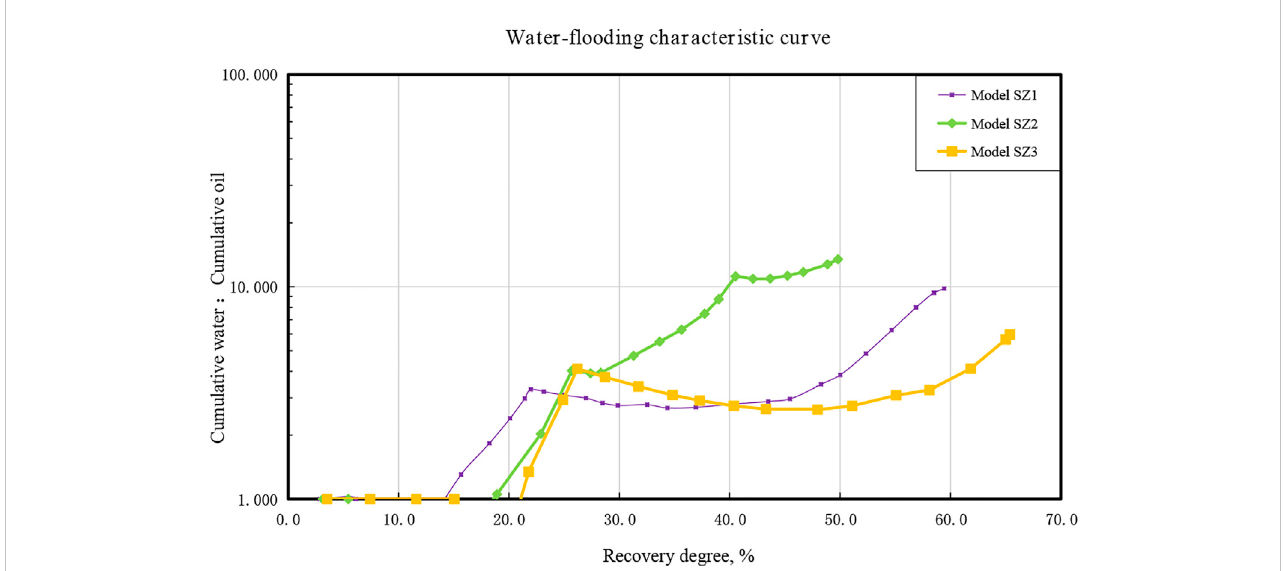
FIGURE 4 Water- fl ooding characteristic curve of positive rhythm model.